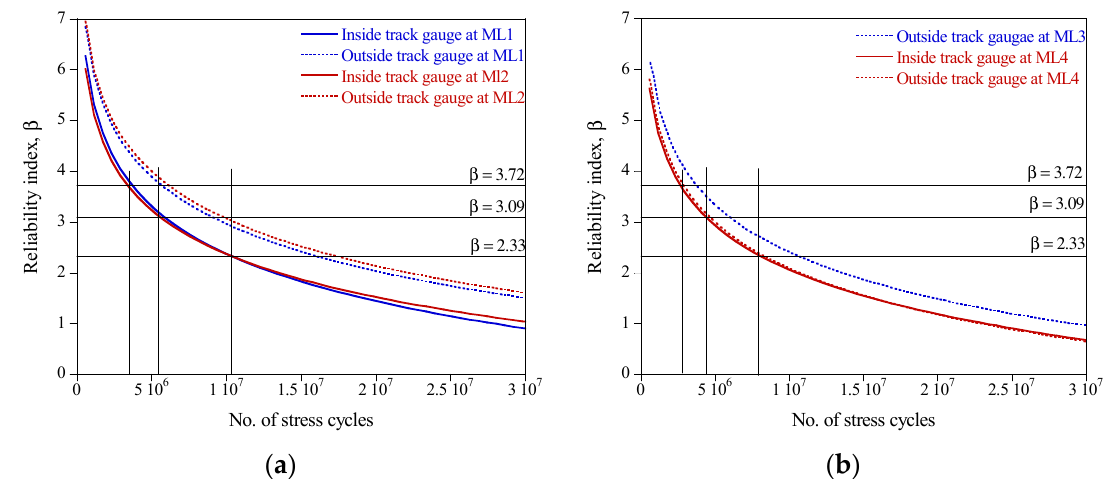
Figure 8. The variations in the reliability index with the accumulated number of stress cycles: ( a ) ML1 and ML2; ( b ) ML3 and ML4.